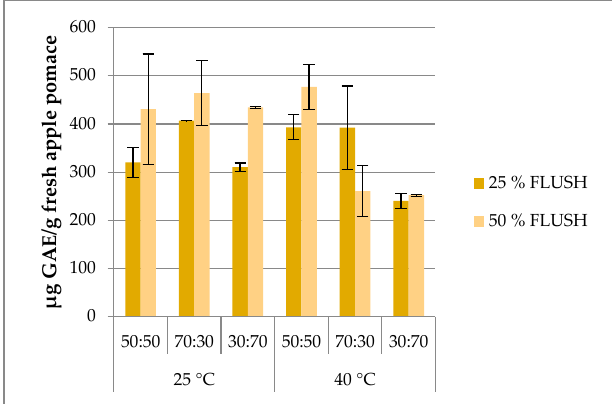
Figure 2. TPC results of ASE extracts. Error bars represent the SD.